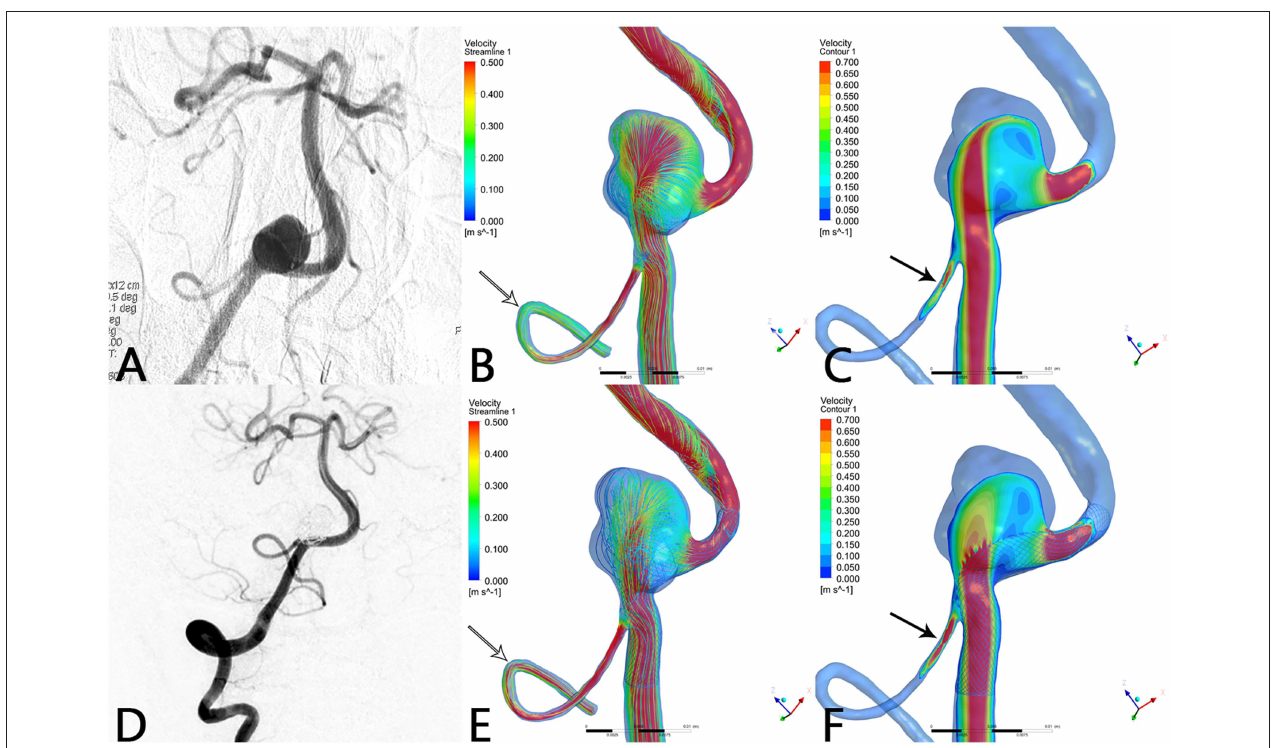
FIGURE 2 | Case of a right vertebral artery aneurysm treated by PED. (A) Right vertebral artery angiogram showing a V4 segment aneurysm. (B) Preoperative streamline of aneurysm and PICA. (C) Preoperative velocity contour of aneurysm and PICA. (D) Angiogram at 6-month follow-up shows that the aneurysm reached complete occlusion with patency of PICA. (E) Postoperative streamline of aneurysm and PICA. The streamline in the aneurysm became sparser compared with preoperatively. Unexpectedly, the streamline in PICA increased (white arrow) compared with (B) . (F) Post-operative velocity contour of aneurysm and PICA. Compared with (C) , flow velocity in the aneurysm slowed down markedly, whereas flow velocity in PICA increased substantially (black arrow).